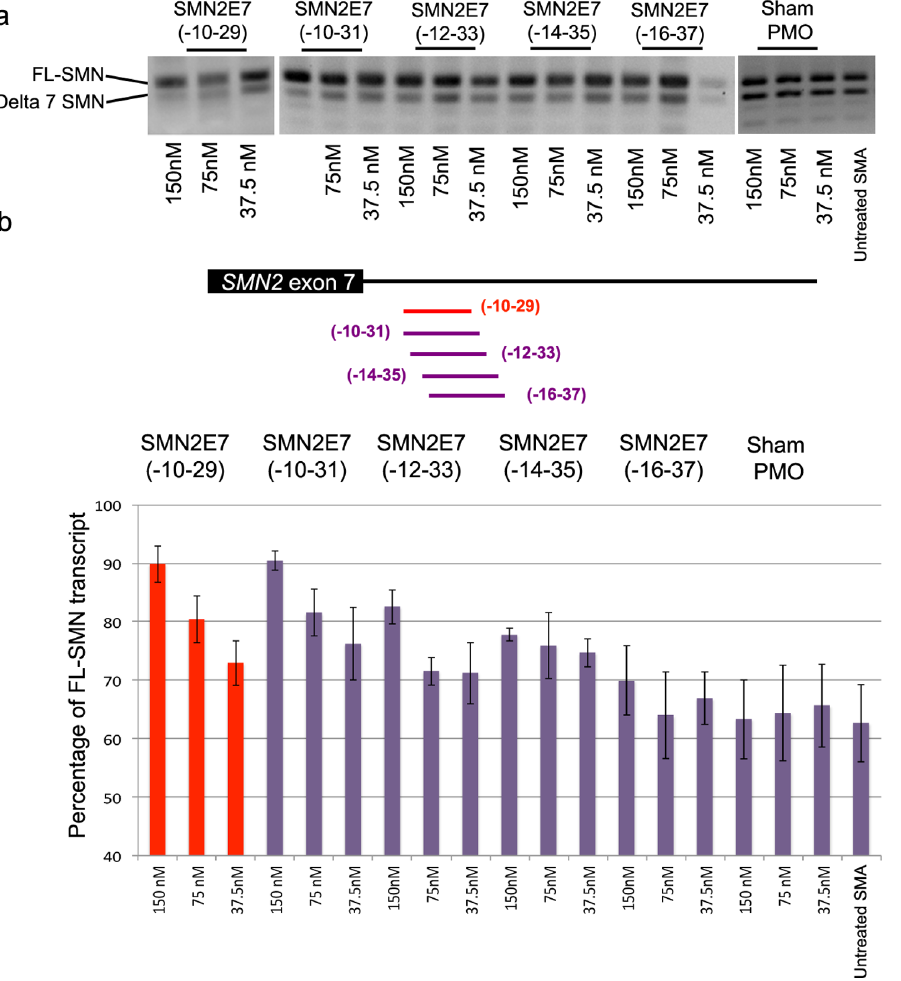
Figure 3. a) Splicing pattern of SMN transcript in type I SMA patient cells transfected with a panel of 22-mer PMOs or unrelated negative control (Sham PMO) using lipofectin. b) The lower panel shows the average percentage of SMN2 exon inclusion as determined by densitometric analysis of RT-PCR gel images.